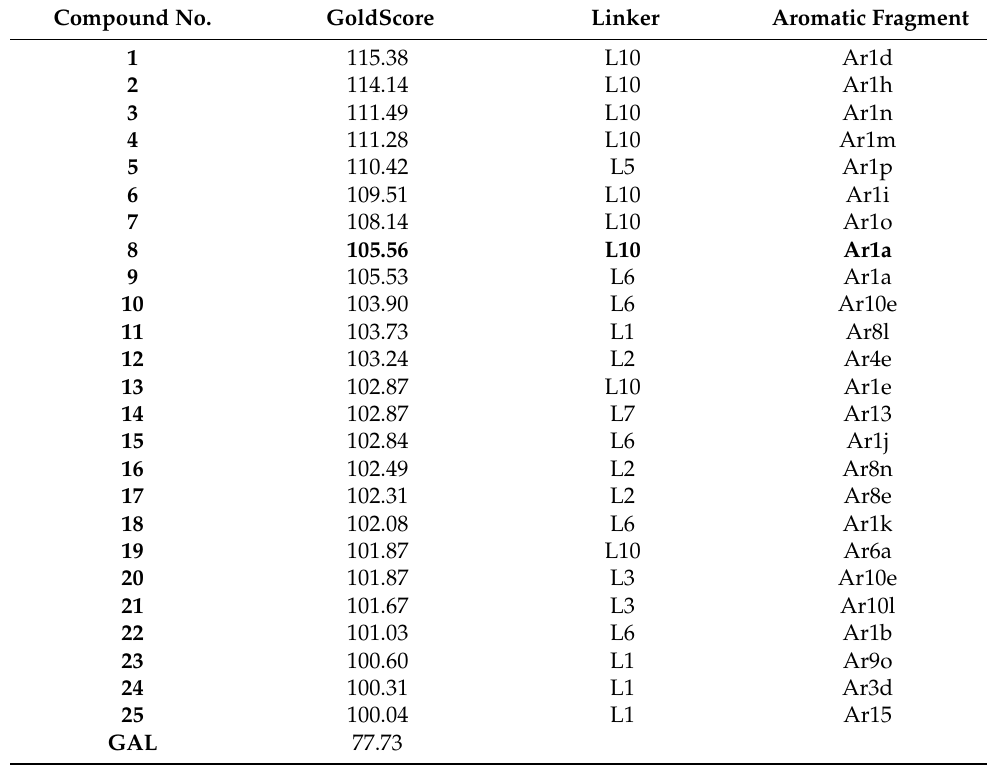
Table 1. The best-scored GAL derivatives with GoldScore >100. Compound 8 (given in bold) was selected for synthesis. Compound No.